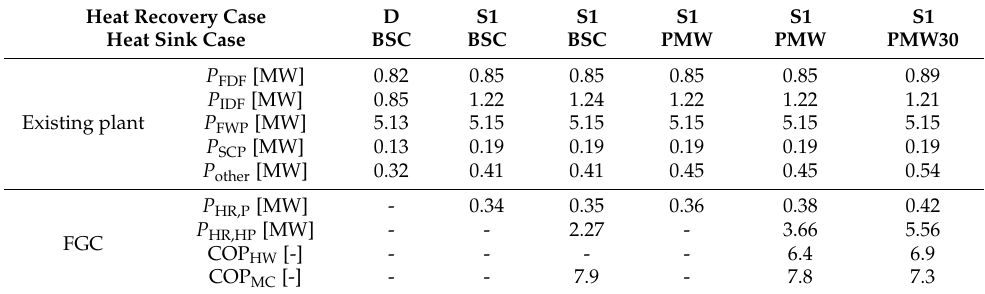
Table A3. Auxiliary power consumption of the simulated cases without CAH.